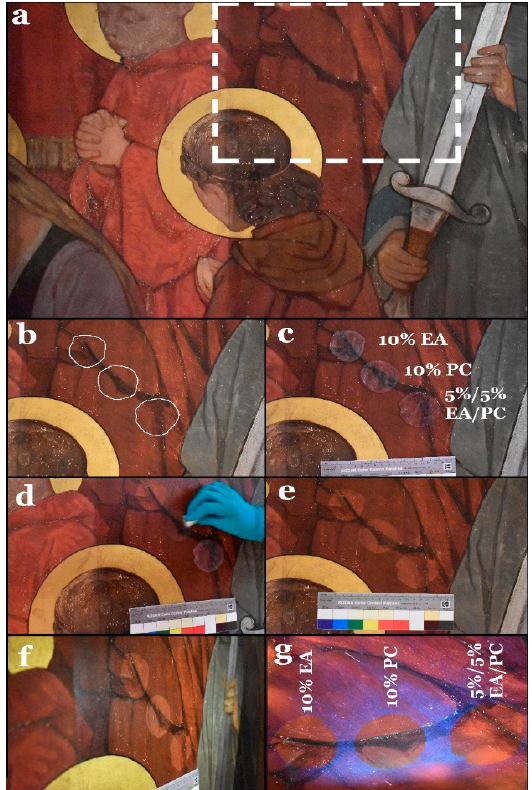
Figure 7. ( a ) General view of the selected area for the second-stage tests. ( b ) Selected areas before gel treatments. ( c ) The selected three hydrogel composites during application. ( d ) Removal of the swelled varnish after peeling off the hydrogel using a dry cotton ball. ( e ) View of the surface after the treatment. ( f ) The same view under raking light. ( g ) The same view under UV light.